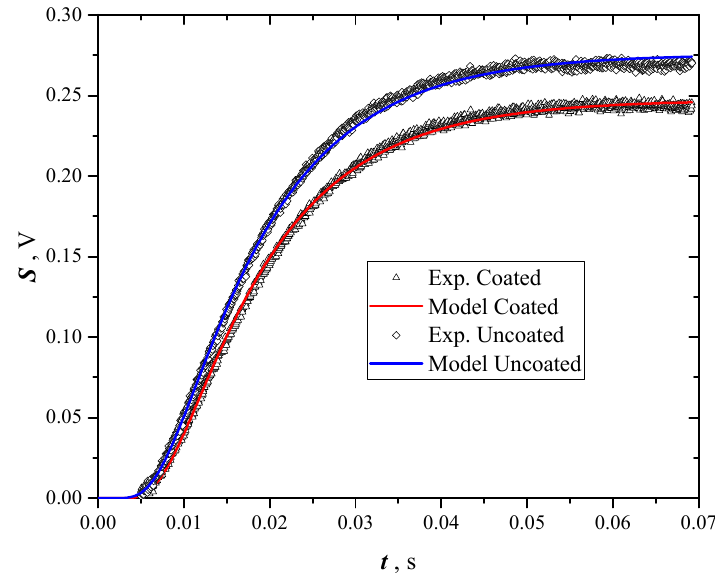
Figure 3 . Overlapping of a typical signal recorded in a test by flash method on GNP coated and uncoated samples.